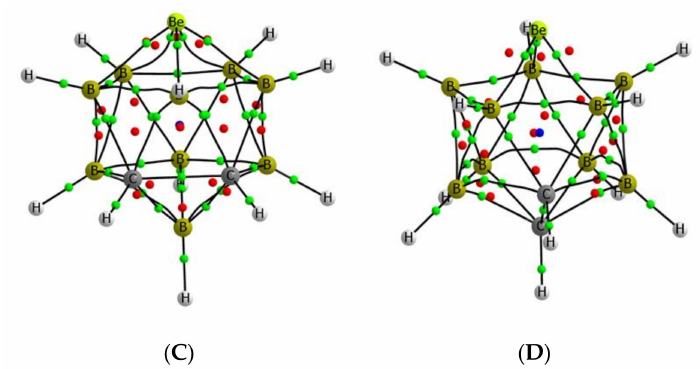
Figure 5. Molecular graph for the four isomers of the beryllium ortho -carboranes investigated. The location of the bond, ring, and cage critical points is indicated with green, red, and blue dots, respectively. A – D the same as in Figure 2.